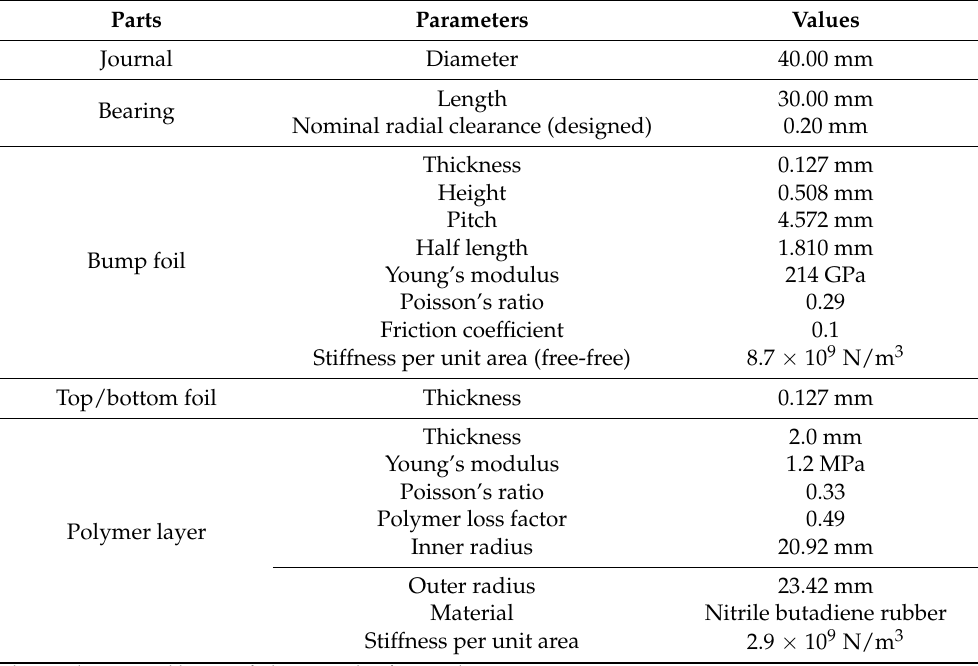
Figure 4. ( a ) Fabricated test GFPB and ( b ) measurement setup of the static-load deflection test with a Figure 4. Fabricated test GFPB and measurement setup of the static-load deflection test with a stationary shaft and a moving bearing housing. stationary shaft and a moving bearing housing. Table 1. Specifications of the test and analysis Table 1. Specifications of the test and analysis GFPB.